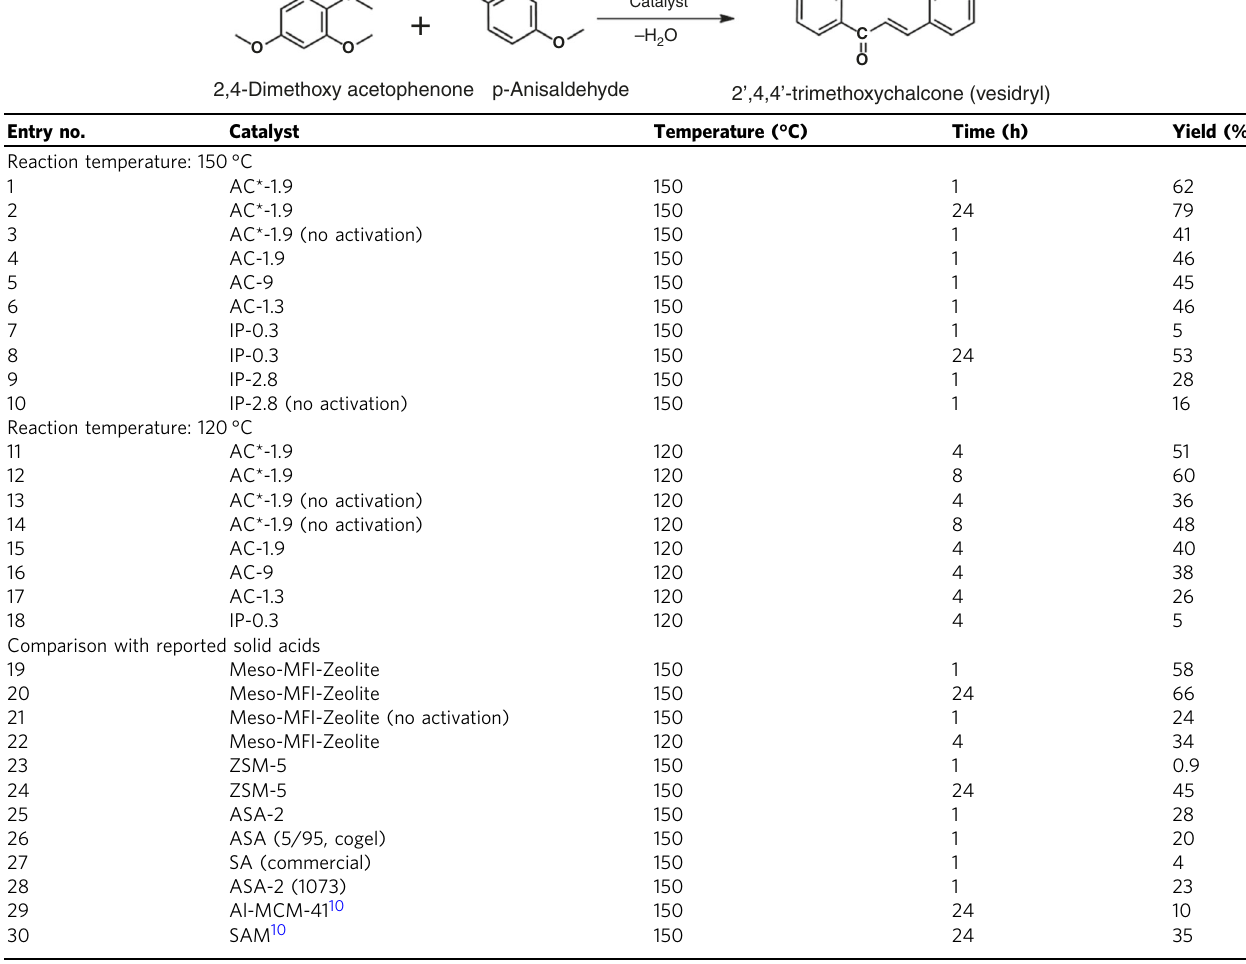
Error in the yield is ±5%.